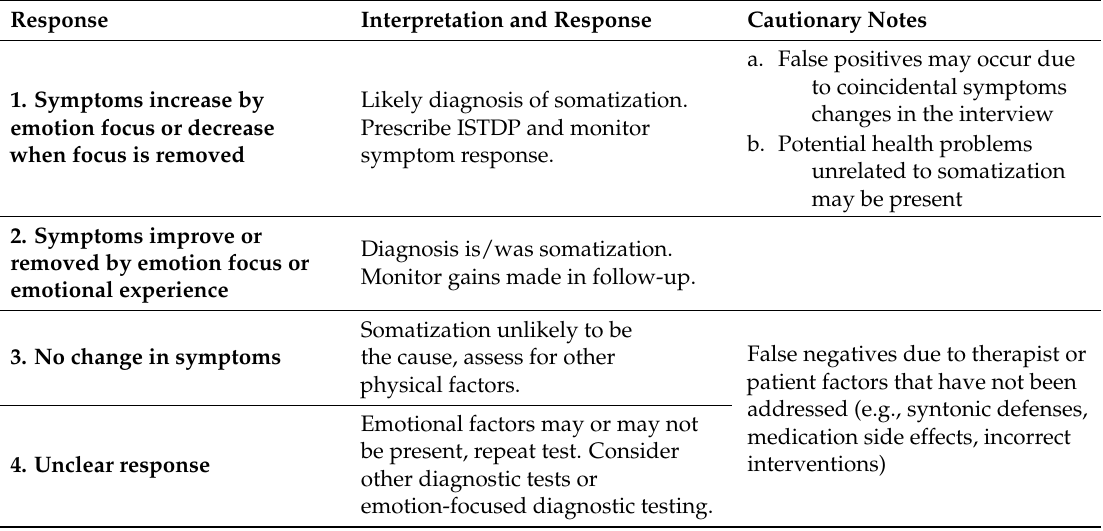
Response and Interpretation from Emotion-Focused Intensive Short-Term Dynamic Psychotherapy (ISTDP)